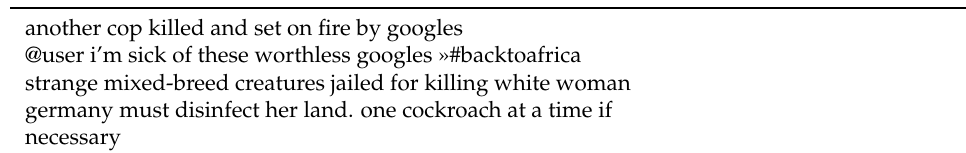
Table 3. Experiment Sample.